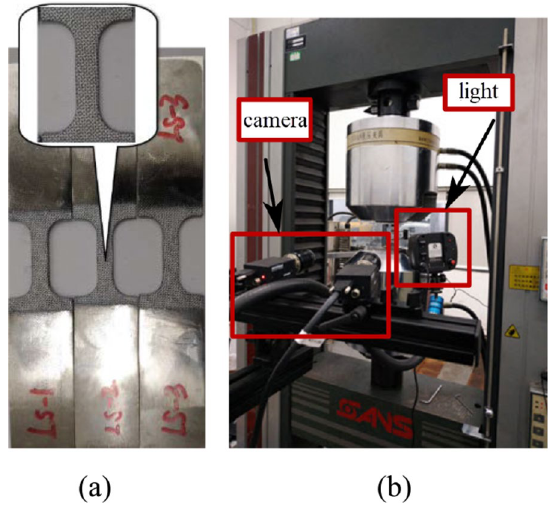
Figure 2 Specimens with speckle pattern and Quasi-static testing system